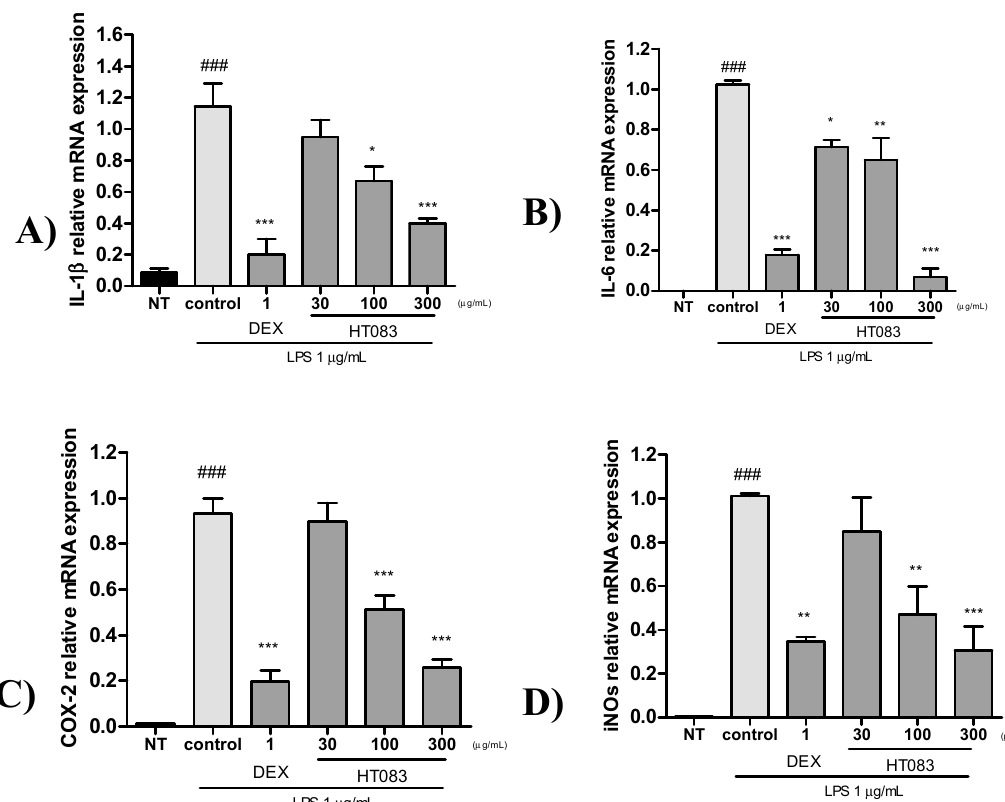
Figure 7. Quantitative Real Time-PCR (qRT-PCR) analysis of IL-1 β , IL-6, COX-2, and iNOS mRNA expression in LPS-stimulated RAW264.7 cells. Cells were pretreated with positive control, Dexmethason 1 µ g / mL and HT083 (30, 100, 300 µ g / mL), and then incubated with LPS for 24 h. The cells were lysed, and total RNA was subjected to quantitative Real Time-PCR with the primers IL-1 β , IL-6, COX-2 and iNOS ( A – D ). Each experiment was repeated three times. Each value is the mean ± SEM. The number of animals is nine per group; * p < 0.05, ** p < 0.01 and *** p < 0.001 vs. control; ### p < 0.001 no treatment (NT) (one-way ANOVA, Dunnett’s post hoc test).